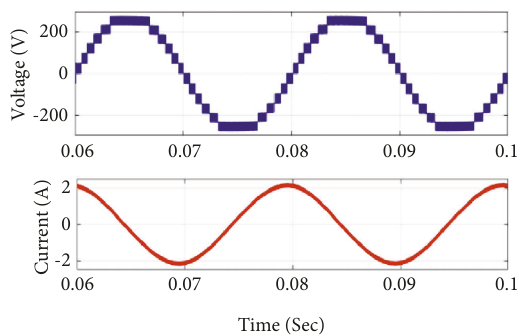
Figure 10: MLI output voltage (MI-0.7).